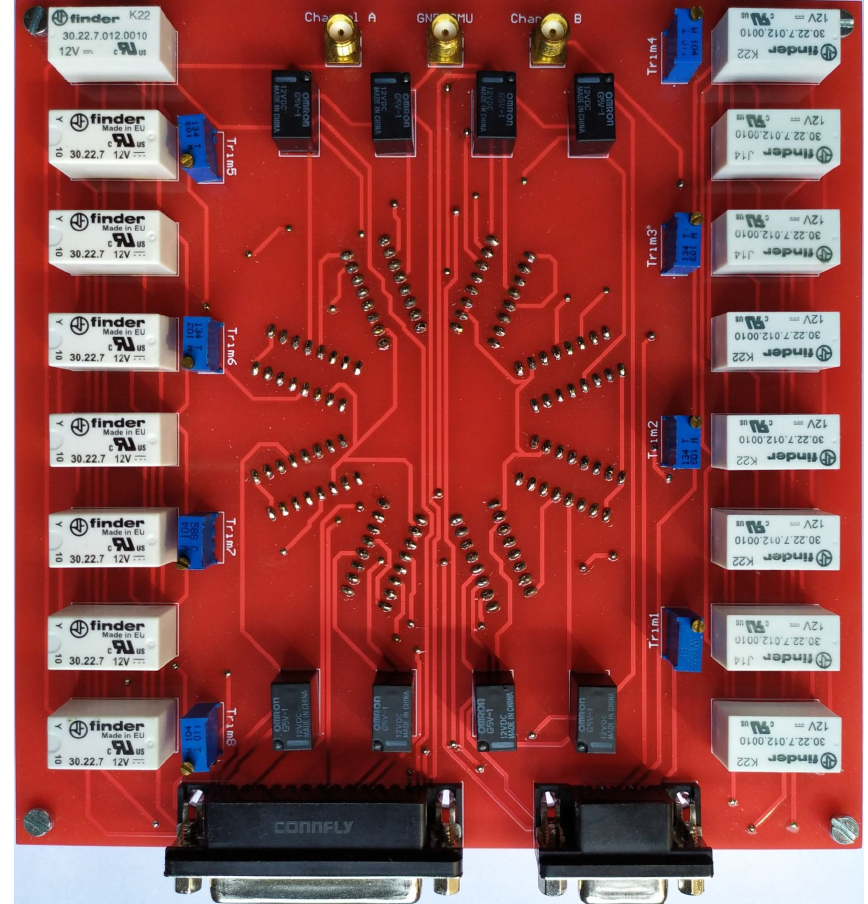
Figure A4. PCB top of mainboard with